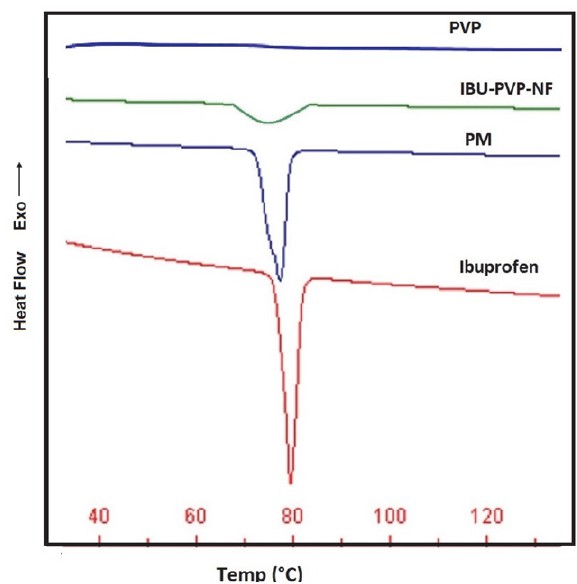
Fig 3. DSC thermograms of the studied samples indicate sharp melting endotherms at the melting point of ibuprofen in raw ibu- profen (Ibuprofen) and physical mixture (PM) samples. Ibupro- fen-loaded nanofiber sample (IBU-PVP-NF) lacks a sharp endo- thermic peak. PVP nanofiber sample (PVP) exhibited no endothermic peak indicating its amorphous nature.